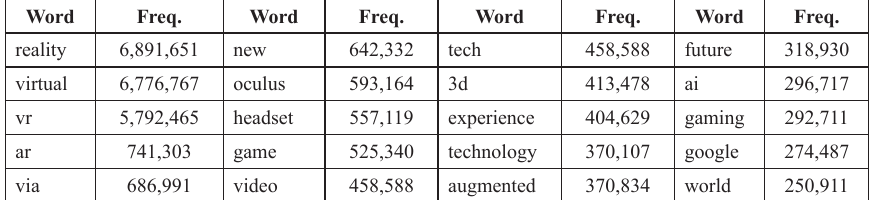
Table 1. Frequency of the top-20 most commonly used words within the tweets